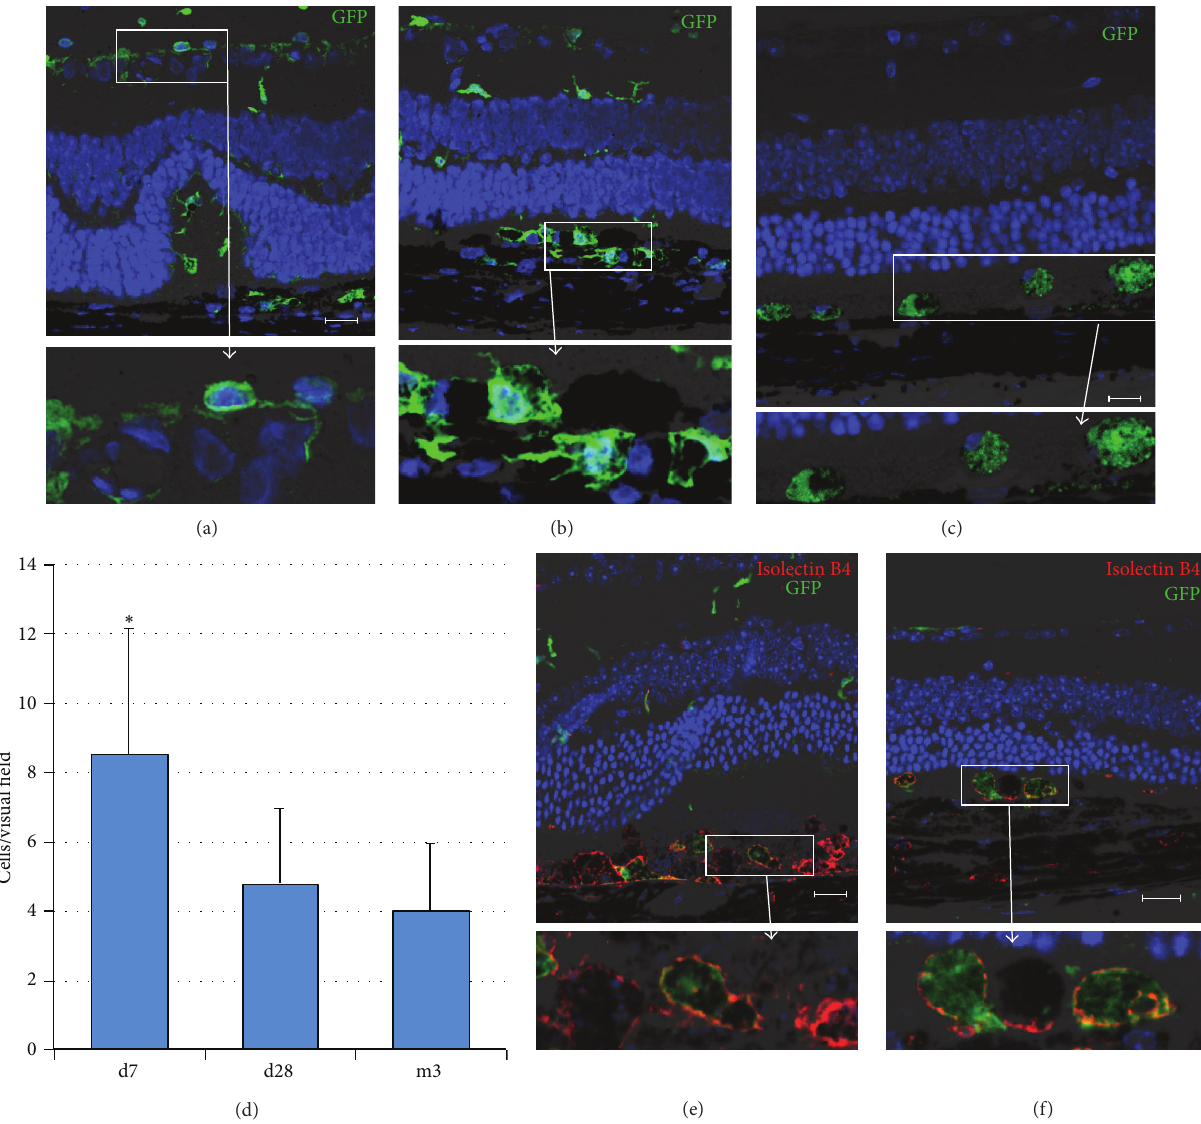
Figure 3: Longitudinal follow-up of the fate of Lin − BMCs at different time points post intravitreal transplantation. Immunofluorescence analysis of retinas after intravitreal GFP + Lin − BMCs delivery showed transplanted cells (green) on the 7th day (a, b) and at 3 months after injection (c). Quantitative analysis of the total number of incorporated Lin − BMCs per eye section ( 𝑛 = 5 /time point) (d). Coreactivity of GFP (green) and Isolectin-B4 (red) by fluorescent lectin staining showed that transplanted GFP + Lin − BMCs locally differentiated into Isolectin- B4-positive macrophages (inserts) in Lin − BMC-injected eyes on the 7th day after transplantation (e) and at 3 months after injection (f). Scale bar = 20 𝜇 m. ∗ 𝑃 < 0.05 for day 7 versus other time